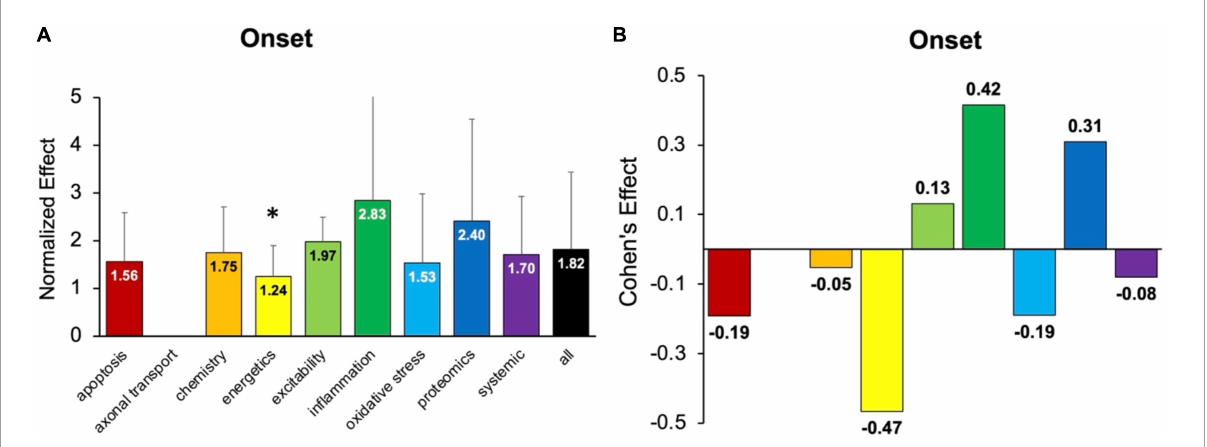
FIGURE3 Assessment of pathophysiological treatment category on delaying onset. (A) Normalized effect size for onset metrics for each pathophysiological treatment category. Error bars represent standard deviation. Axonal transport was omitted due to inadequate sample size. Each pathophysiological treatment category was compared to the “all” treatments category (black bar) with ∗ denoting a significant difference ( p < 0.05). (B) Calculated Cohen’s effect size for symptom onset for each pathophysiological treatment category. Cohen’s effect is a statistical measure of each pathophysiological treatment category’s effect size on onset relative to “all”